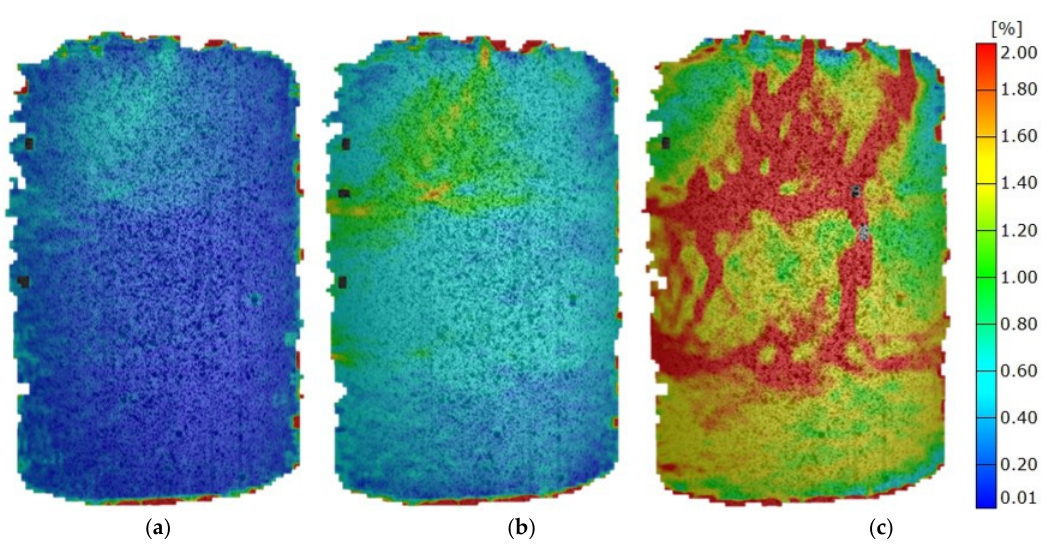
Figure 11. Mises strain at various load stages of mixtures with no stabilisation. ( a ) 0.3 F max ; ( b ) 0.6 F max ; ( c ) 1.0 F max .